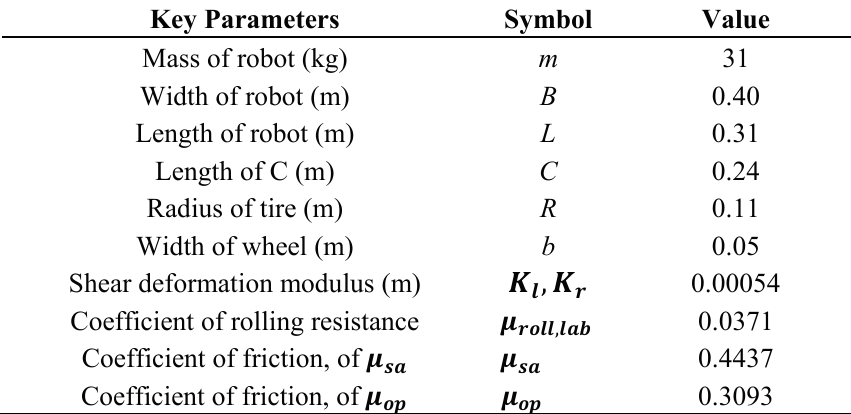
Table 1. The parameters for Pioneer P3-AT robot and terrain dynamic model. Key